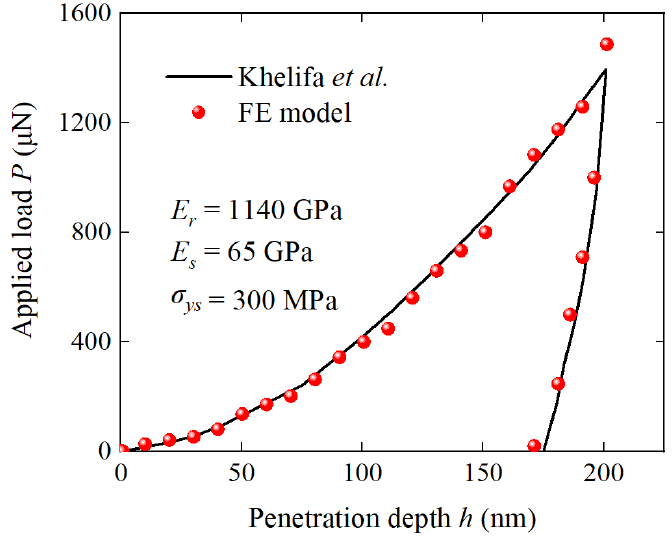
Figure 4. Response comparison of the established FE model and published result [35].